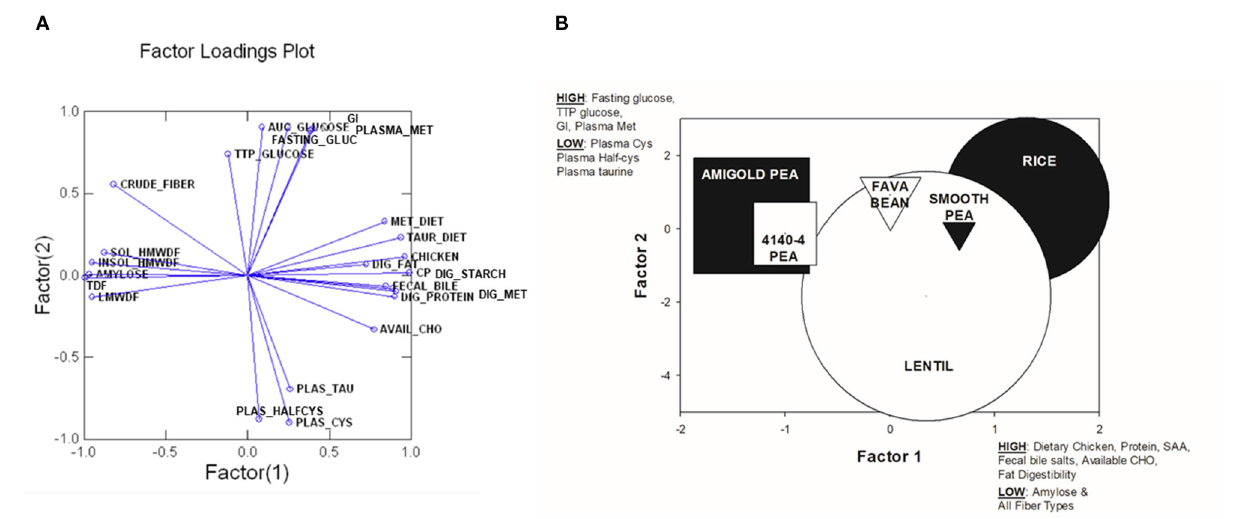
FIGURE 3 | Plots from Principal Components Analysis of the top 24 variables that explained the most variability among diets. (A) Factor loadings plot for factor 1 and factor 2. (B) A plot of weighted factor scores for components 1 vs. components 2 for each test diet in this study from the Principal Components Analysis. The size of the shape indicates the 95% confidence intervals and distance between shapes indicates greater difference among diets. Higher, positive scores for Factor 1 were associated with high dietary chicken content, dietary crude protein, dietary sulfur amino acid content (SAA; cysteine, methionine and taurine), fecal bile salts, dietary available carbohydrate and fat digestibility, but low amylose and all fiber types. In contrast, a high positive score for Factor 2 was associated with high fasting blood glucose, long time to peak blood glucose, high glycemic index and high plasma methionine, but low plasma cysteine, plasma half-cysteine and plasma taurine. SOL_HMWDF, soluble high molecular weight dietary fiber; INSOL_HMWDF, insoluble high molecular weight dietary fiber; TDF, total dietary fiber; LMWDF, low molecular weight dietary fiber; TTP_GLUCOSE, time to peak glucose; FASTING_GLUC, fasting blood glucose; AUC_GLUCOSE, area under the curve for